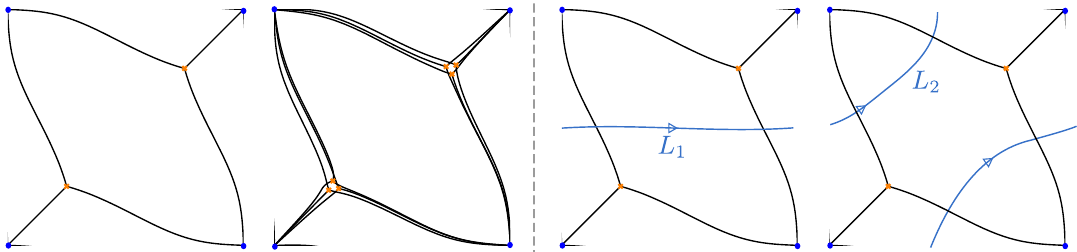
Figure 45 . Far left: a spectral network on the punctured torus, made up of critical leaves associated to φ described in the main text, and φ 2 same φ and the small perturbation φ 2 loops on the punctured torus.